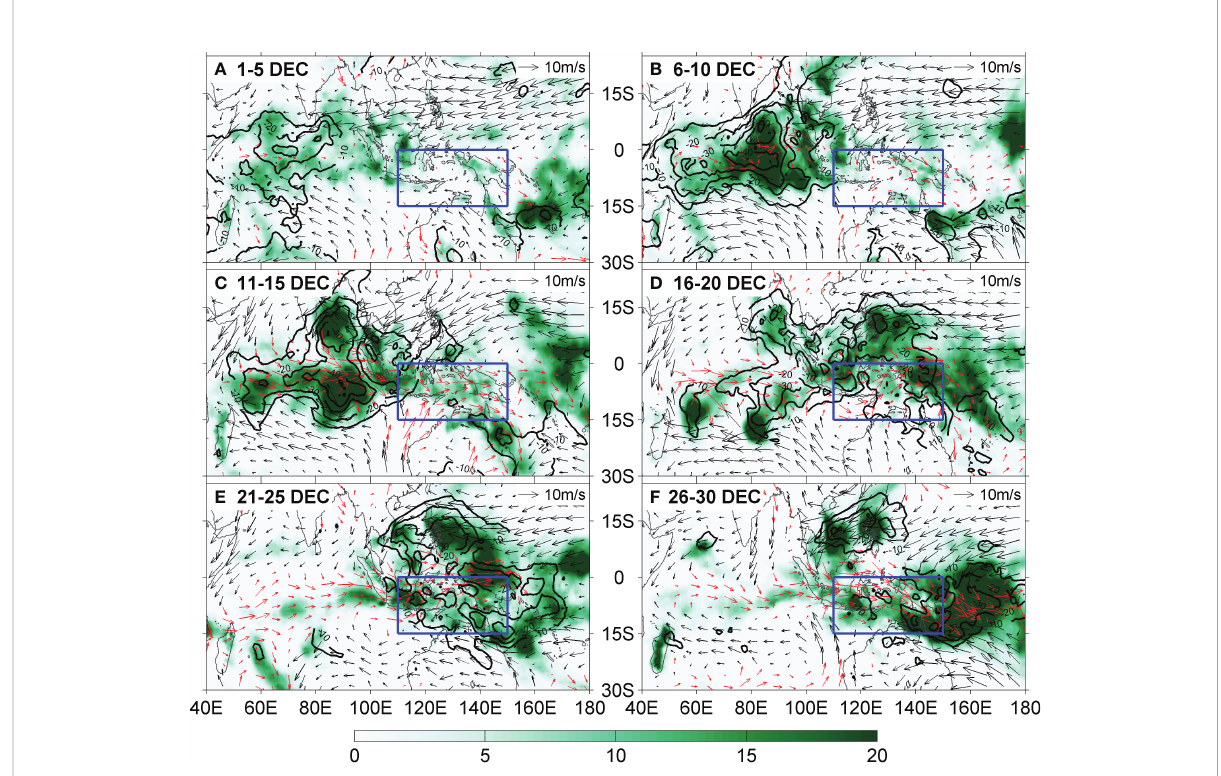
FIGURE 3 Evolution of the pentad-averaged precipitation (shaded; mm day − 1 ), wind fi eld (vectors; m s − 1 ), and 30 – 60-day OLR anomaly (contours; only values lower than − 10 W m − 2 are plotted) for December